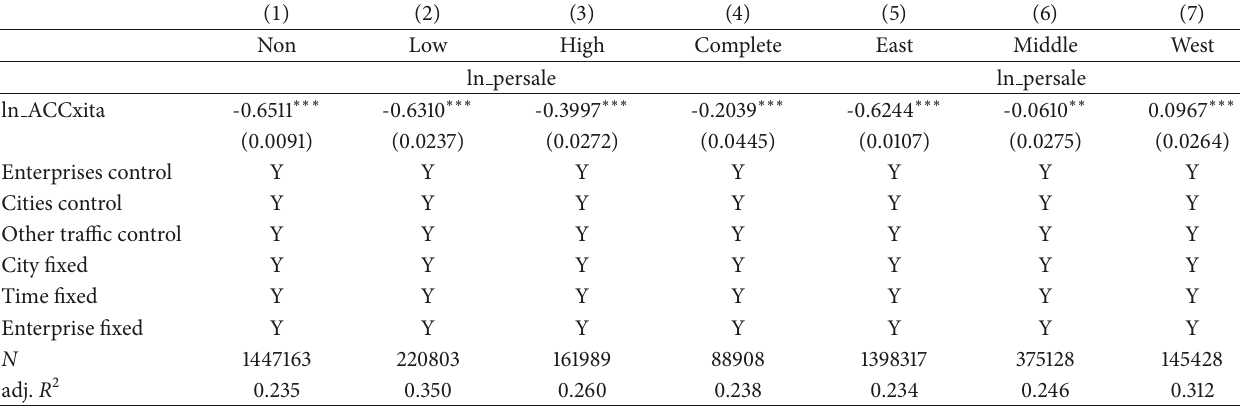
Table 8: Regression results of different export intensity and regional productivity in peripheral cities.